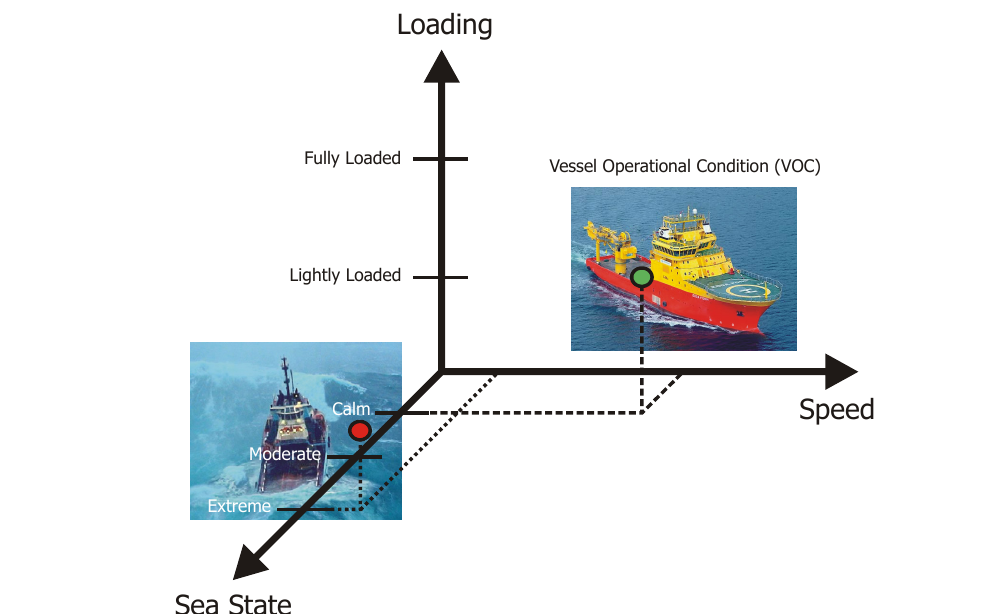
Figure 7: The main axes of speed, sea state, and loading constituting the vessel operational condition (VOC) space. Adapted from (Perez et al.,